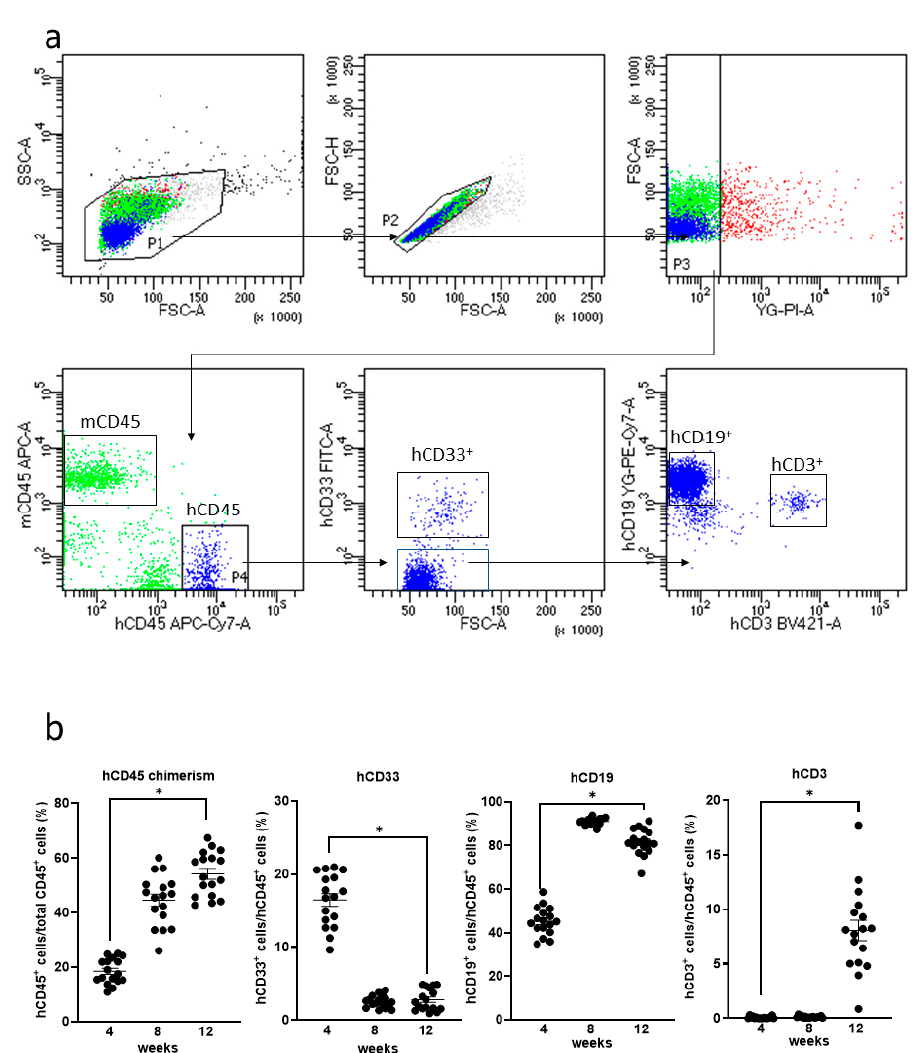
Figure 2. Human lymphocytes expression in the NOG-HLA-A2 Tg (transgenic) (NOD.Cg-Prkdcscid Il2rgtm1Sug Tg(HLA-A*0201/H2-Kb)A0201/Jic) mice peripheral blood. ( a ) Gating strategy of the human lymphocyte is shown. ( b ) Quantification of the human lymphocyte. hCD45 chimerism (left-top), hCD33 + cells (right-top), hCD19 + cells (left-bottom), and hCD3 + cells (right-bottom). Two-way repeated measure ANOVA with Tukey’s multiple comparisons tests were used. ns: no significant difference, * p < 0.0001, n = 17.